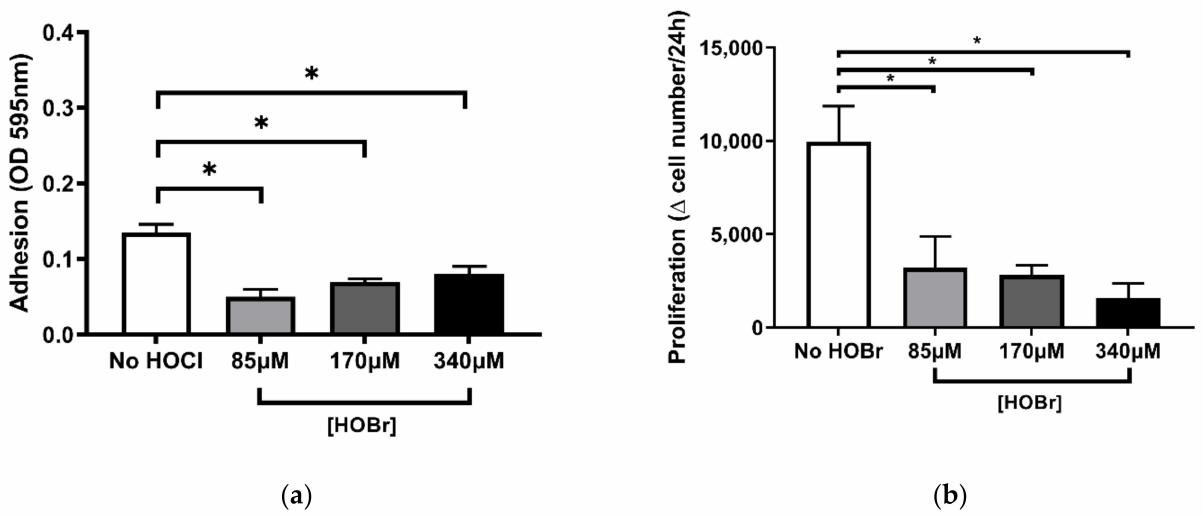
Figure 4. HOBr-induced oxidation of cell-derived ECM showed similar effects on fibroblast adhesion and proliferation compared to HOCl. BEAS-2B-derived ECM was oxidised with (or without) HOBr concentrations of 85 µ M, 170 µ M, and 340 µ M and seeded with PHLF for 2 h ( a ) and for 96 h ( b ). ( a ) Attachment was assessed by Coomassie brilliant blue staining; ( b ) manual cell counts. Results are averages of the ∆ (changes) in cell number per 24 h and expressed as mean ± SEM. A, B n = 5. * p < 0.05, significance was compared against No HOBr control; one-way ANOVA with Dunnett’s multiple comparison test was